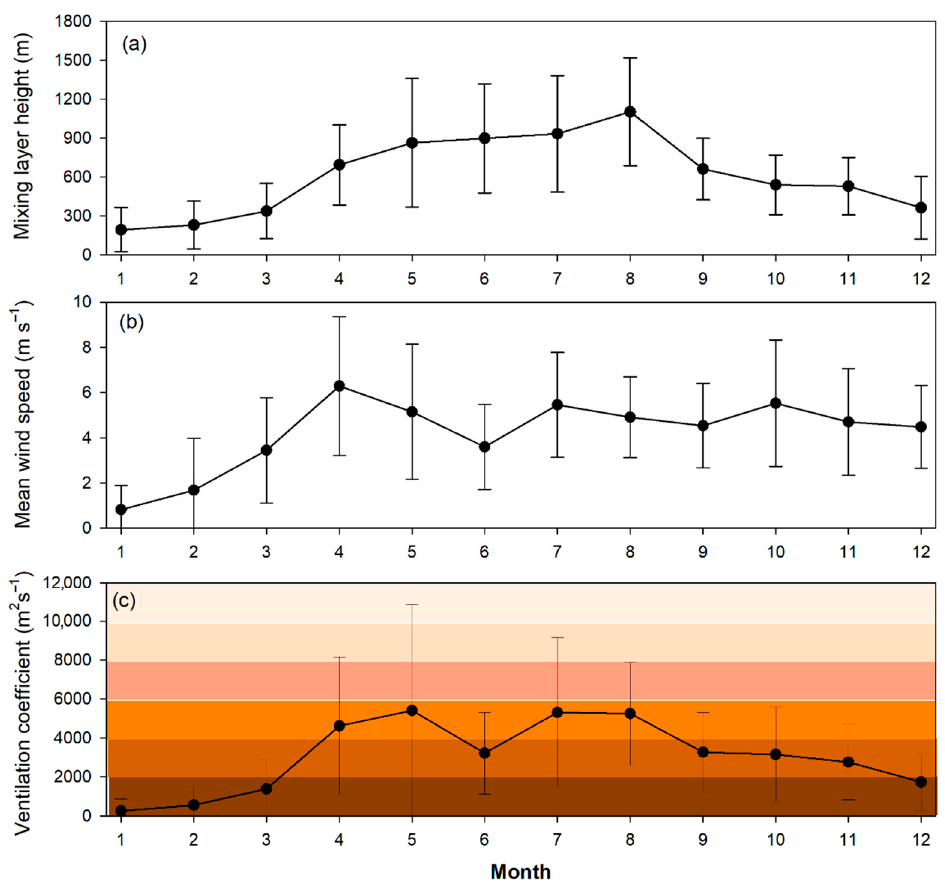
Figure 11. Monthly variations in boundary layer height ( a ), the mean wind speed within the boundary layer ( b ), and the ventilation coefficient ( c ). The colored pattern is air pollution potential categories: a shift from darker to lighter colors corresponds to a decrease in air pollution potential, indicating cleaner air.